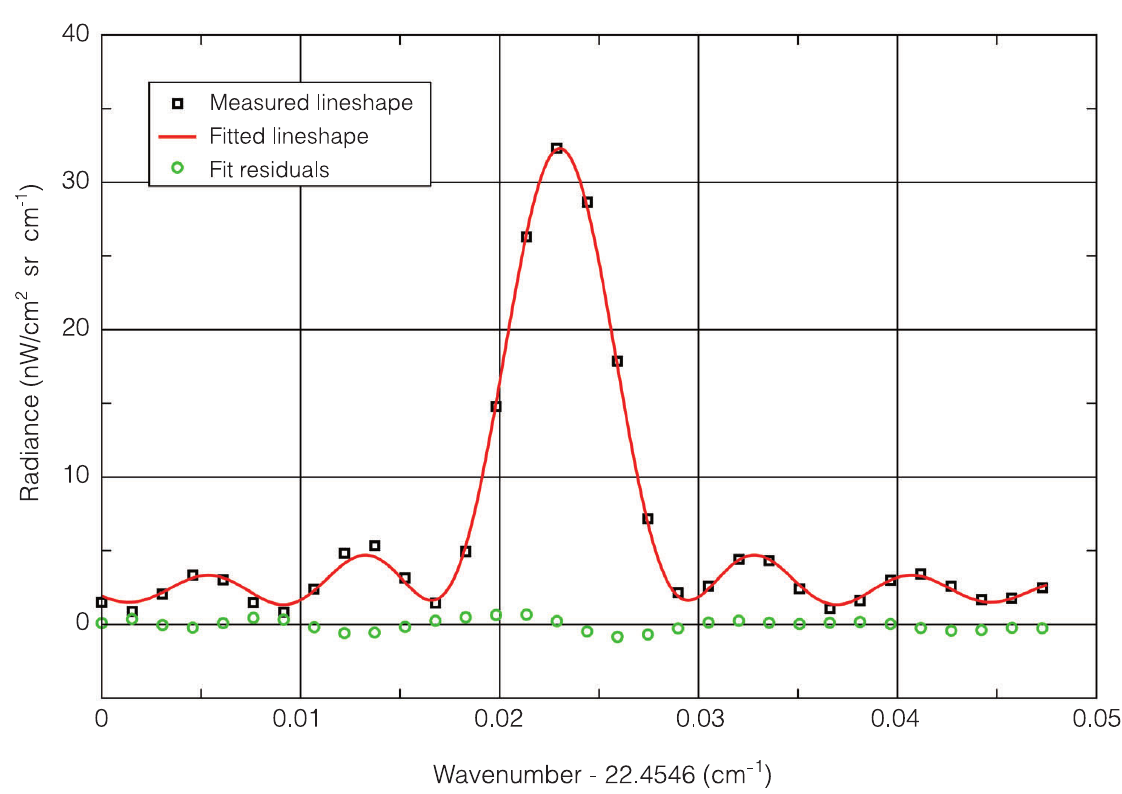
Fig. 10. Instrumental Line Shape (ILS) of the SAFIRE-A spectrometer (fl ight